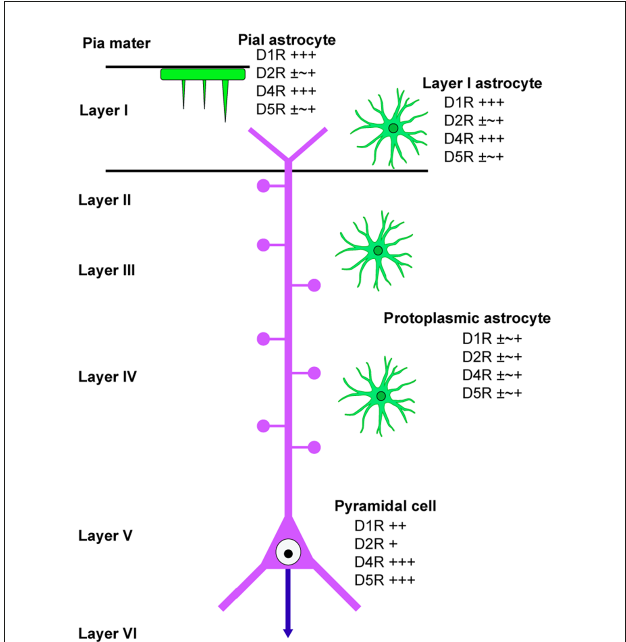
FIGURE6 Scheme of dopamine receptor localization in cortical astrocytes. A scheme summarizes the immunolocalization of dopamine receptors in cortical astrocytes. Protoplasmic astrocytes in layer II and deeper layers are similar in terms of dopamine receptor immunolocalization, which is different from layer I astrocytes. A pyramidal cell in layer V of the primary motor area is also